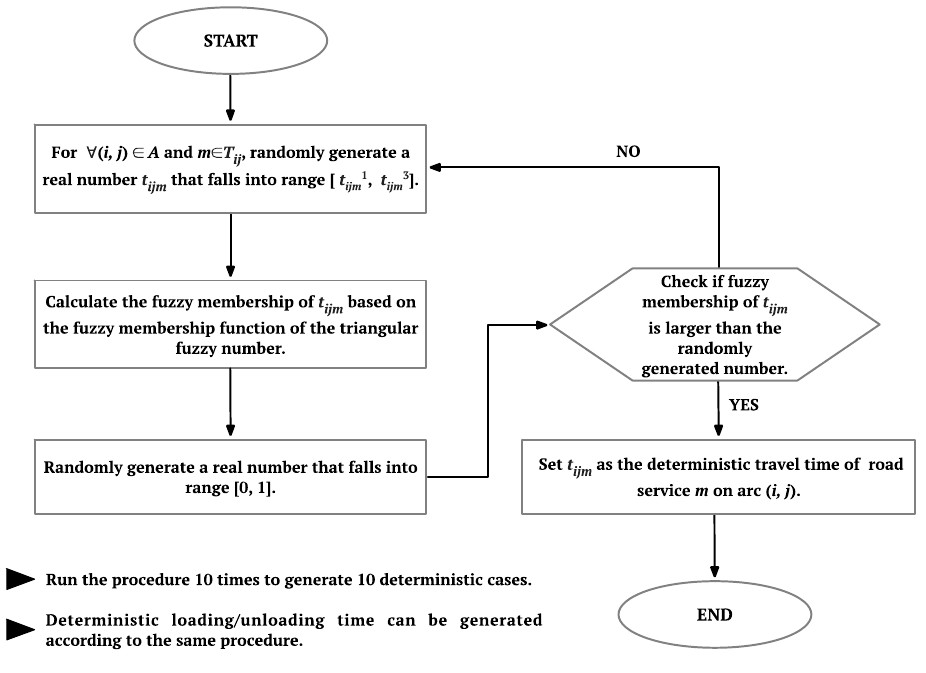
Figure 15. Fuzzy simulation used to generate deterministic cases.